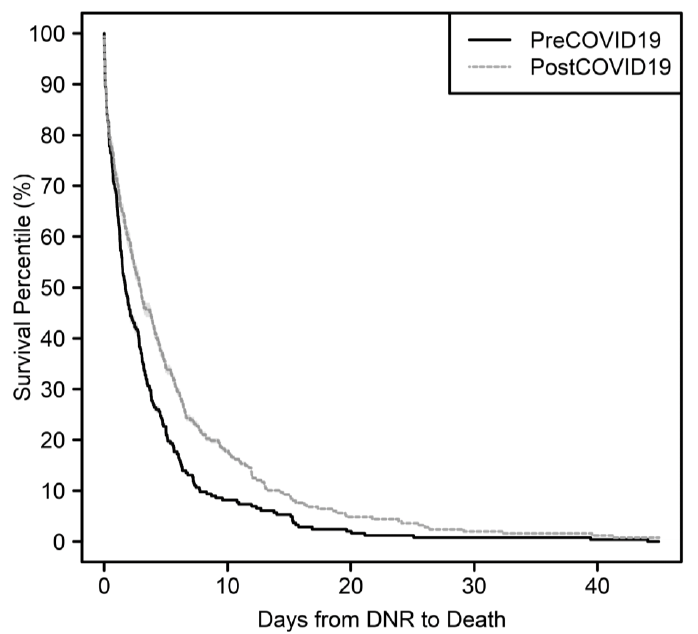
Figure 1. Kaplan-Meier summary of time from DNR order to death